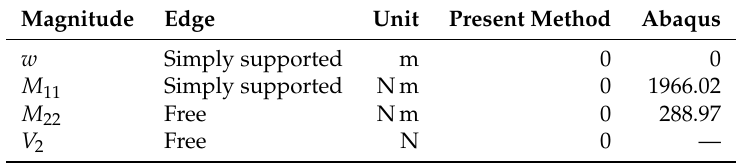
Table 2. Compliance with boundary conditions at the midpoints of the